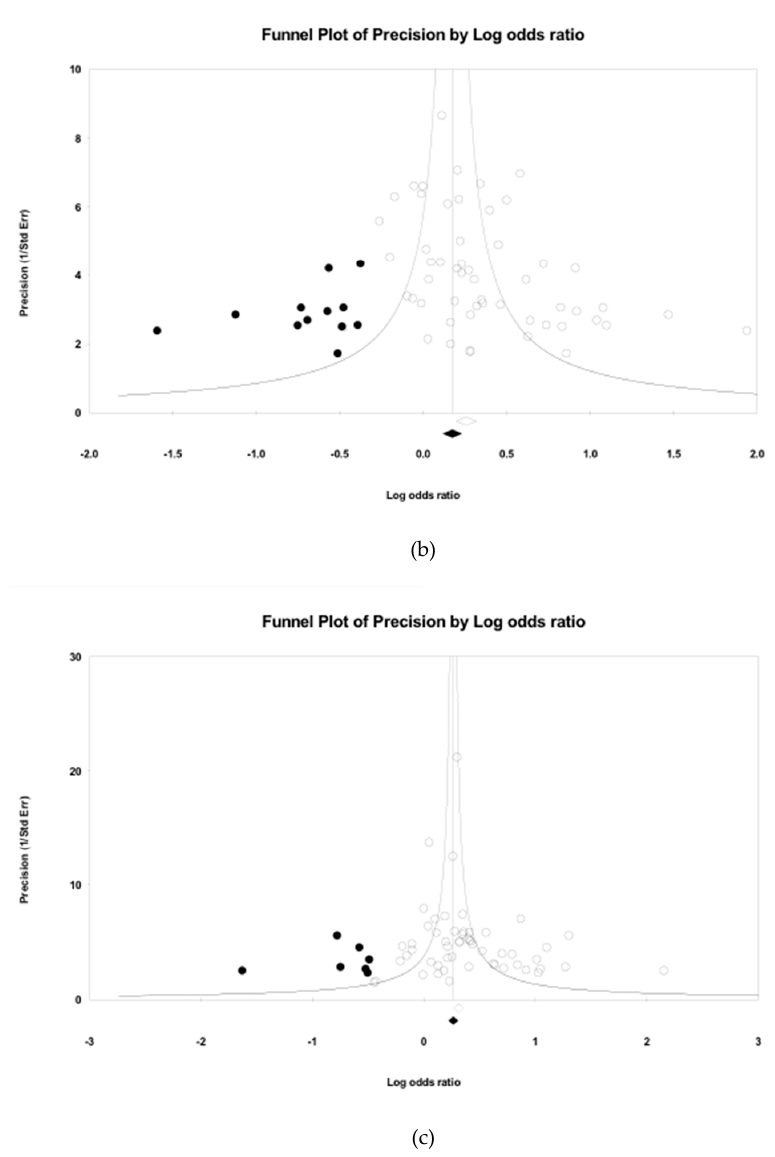
Figure 2. Funnel plot of precision by log odds ratio of long working hours on occupational health. Hollow circles are original data and solid circles are imputed data after adjustment for publication bias. (a) Physiological health, (b) mental health, (c) related health.